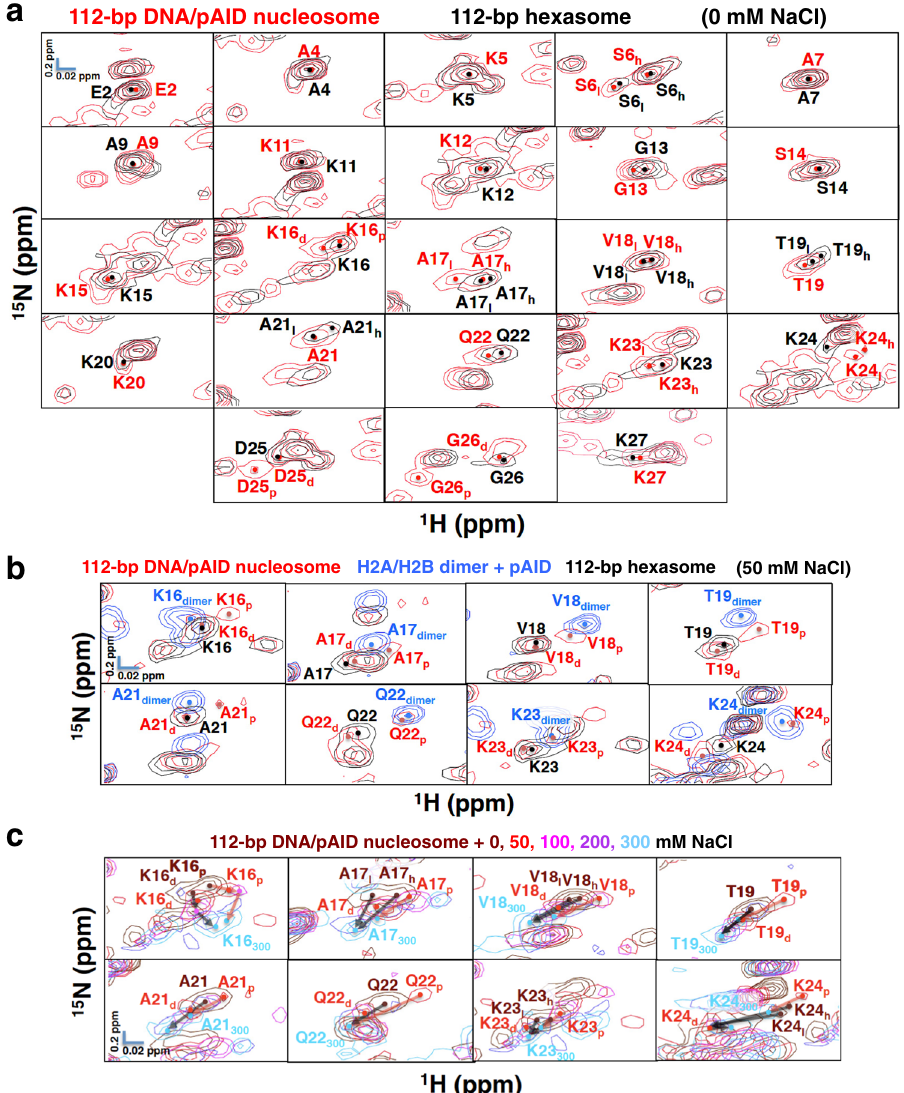
Fig. 3 Establishment of the pAID and DNA sides of the H2B N-tail in the 112-bp DNA/pAID nucleosome. a Comparison of extended HSQC spectra of the H2B N-tail between the 112-bp DNA/pAID nucleosome (red) and the 112-bp hexasome (black) at 0 mM NaCl. NMR signals are divided into panels by amino acid residue of H2B. Signal assignments in the 112-bp DNA/pAID nucleosome and 112-bp hexasome at 0 mM NaCl are labeled in red and black, respectively. Filled circles indicate each signal center. pAID and DNA side signals are designated by subscript p and d, respectively. High- and low- fi eld components of the signals are designated by subscript h and l, respectively. b Expanded signal comparison of the H2B BS2 region among the 112-bp DNA/ pAID nucleosome (red), 112-bp hexasome (black), and H2A/H2B dimer upon the addition of an equivalent amount of pAID (light blue) at 50 mM NaCl. Residues corresponding to signals of the H2A/H2B dimer upon the addition of pAID are designated by the subscript “ dimer ” . c Ionic strength dependence of selected signals of the H2B BS2 region in the 112-bp DNA/pAID nucleosome upon NaCl titration at 0 M (brown), 50 mM (red), 100 mM (pink), 200 mM (purple), and 300 mM (cyan). NMR signals are divided into panels by amino acid residue. Residues are labeled in the color corresponding to the NaCl condition. Residues of the signal at 300 mM NaCl are designated by subscript 300. Red and black arrows indicate the chemical shift changes of the pAID and DNA side signals, respectively, between 0 or 50 mM and 300 mM